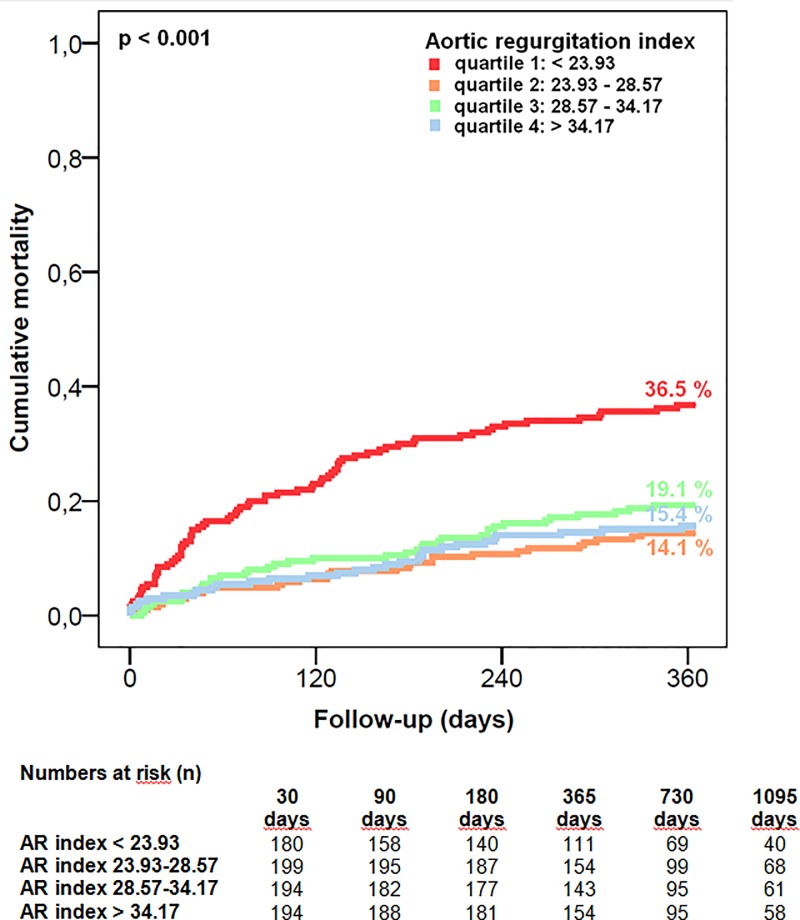
All-cause 1-year mortality according to aortic regurgitation index quartiles.When categorized into quartiles, a post-procedural ARI in the lowermost quartile (<23.93) was significantly associated with increased all-cause mortality at 1 year (Q1: < 23.93: 36.5%, Q2: 23.93–28.57: 14.1%, Q3: 28.57–34.17: 19.1%, Q4: > 34.17: 15.4%; p<0.001).